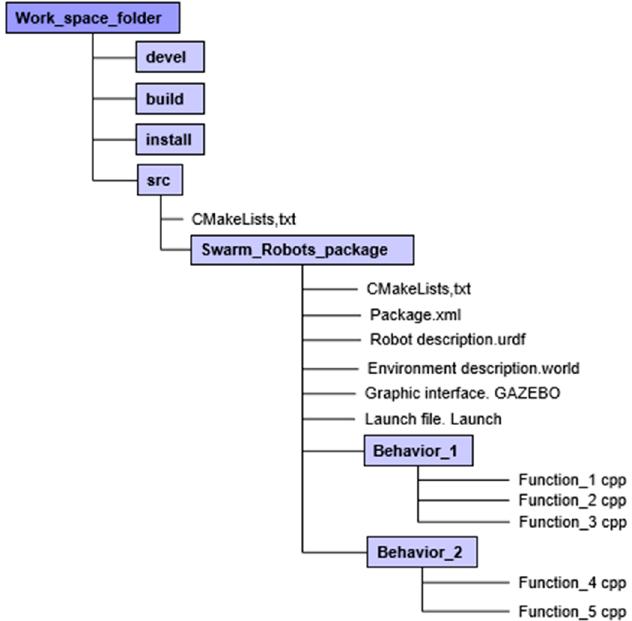
Figure 9. Organization of the workspace of a swarm member in ROS.